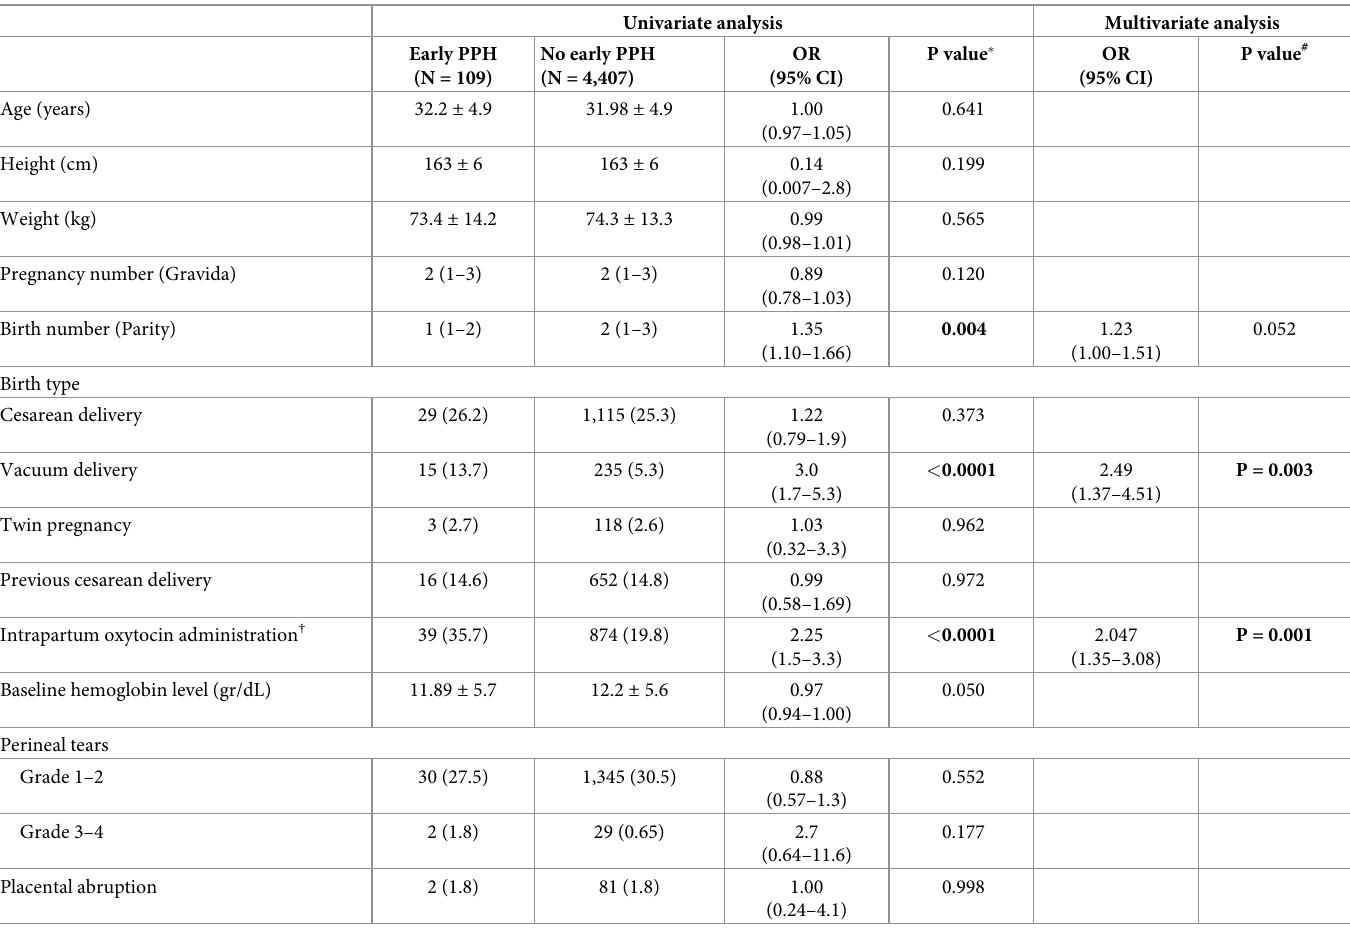
Table 3. Factors associated with early postpartum